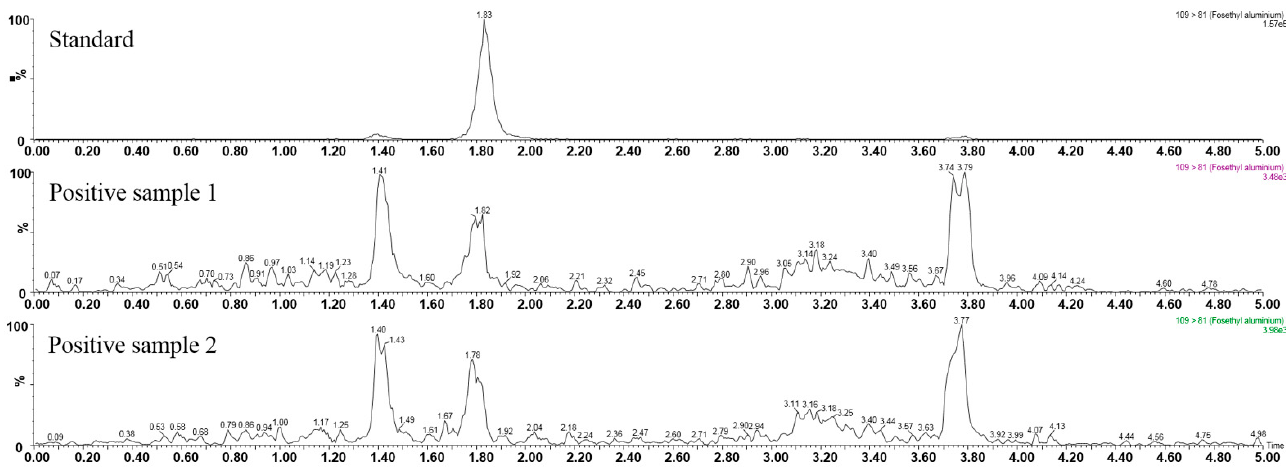
Figure 3. Chromatograms of the positive samples.